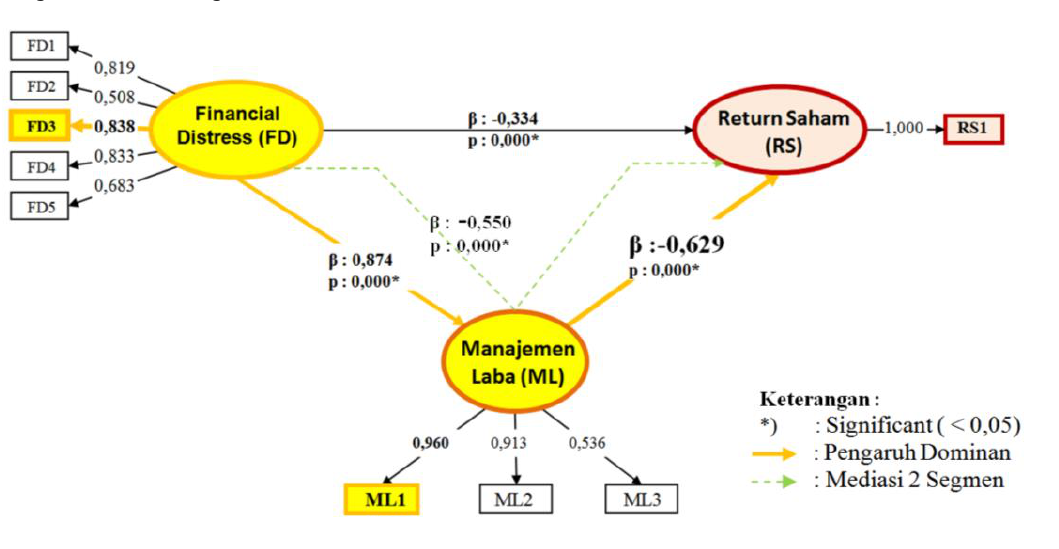
Figure 4: Path Diagram SEM-PLS OverAll Model 1